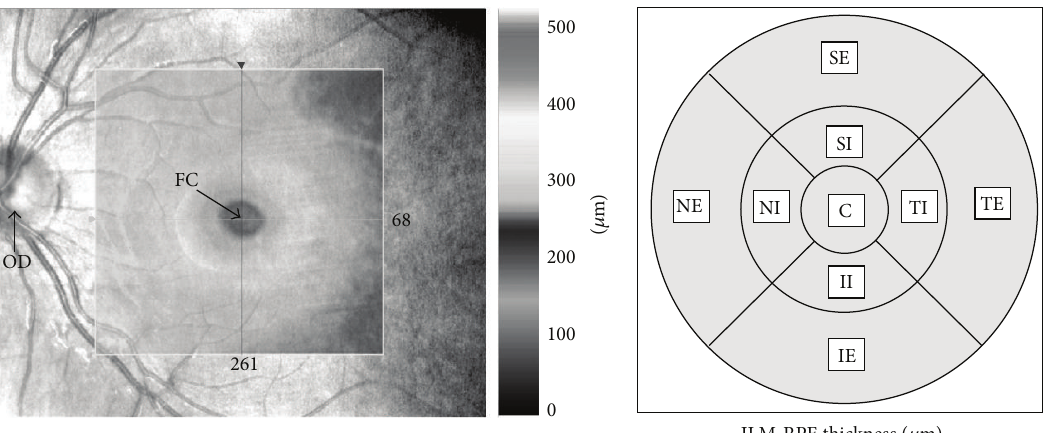
Figure 1: The map was divided into nine ETDRS macular fields. C: central field; SI: superior internal field; TI: temporal internal field; II: inferior internal field; NI: nasal internal field; SE: superior external field; TE: temporal external field; IE: inferior external field; NE: nasal external